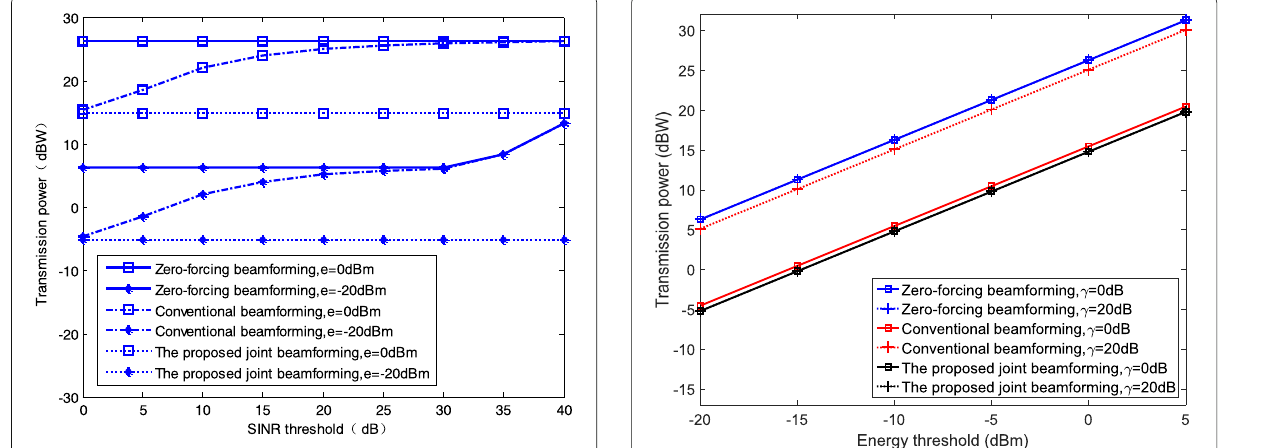
Fig. 5 The relation between transmission power and SINR threshold